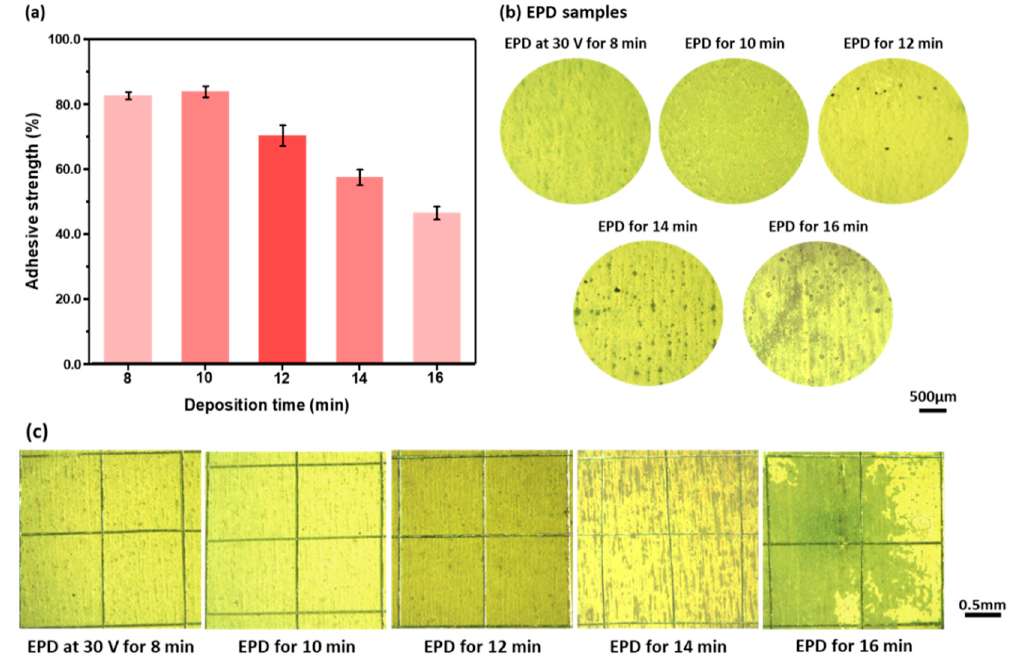
Figure 15. Adhesive strength of the post-treated coatings deposited for a different time during 8 to 16 min ( a ), corresponding microscopic images of the coatings after the adhesive strength test ( b ) and images of the coatings after the cross-hatching tests ( c ).